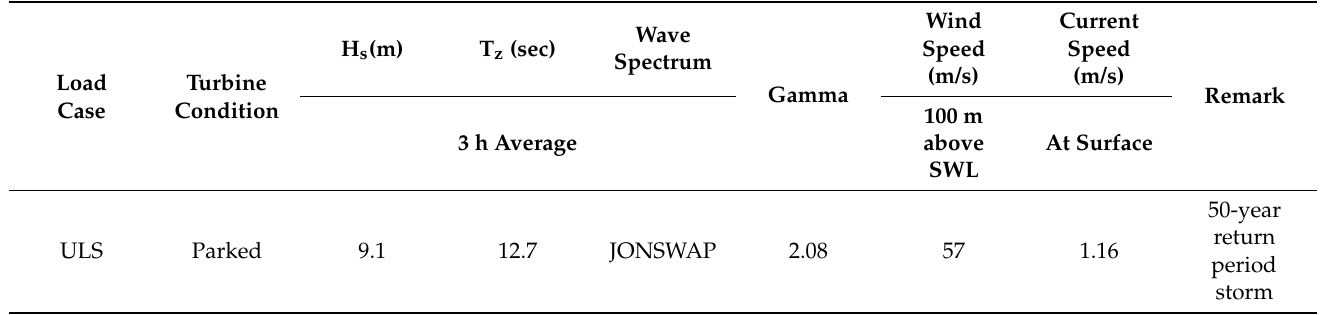
Table 3. Marine data for ULS load case.